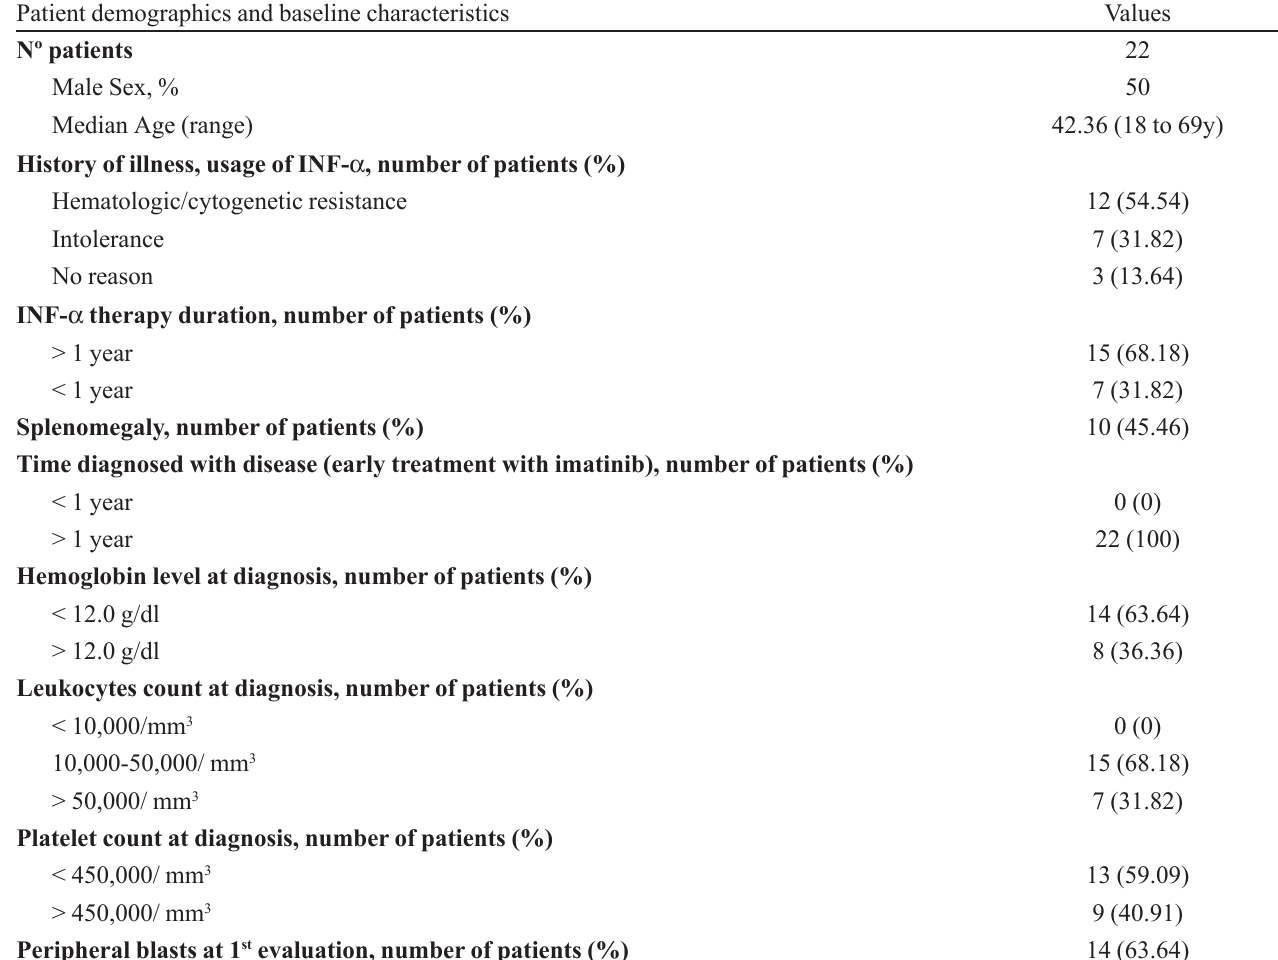
TABLE III - Patient demographics and baseline characteristics Patient demographics and baseline characteristics